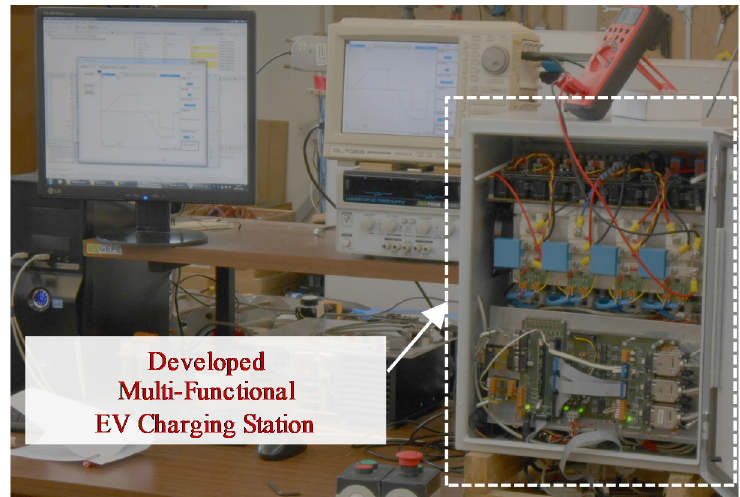
Figure 2. Experimental setup with the developed MF-EVCS prototype.